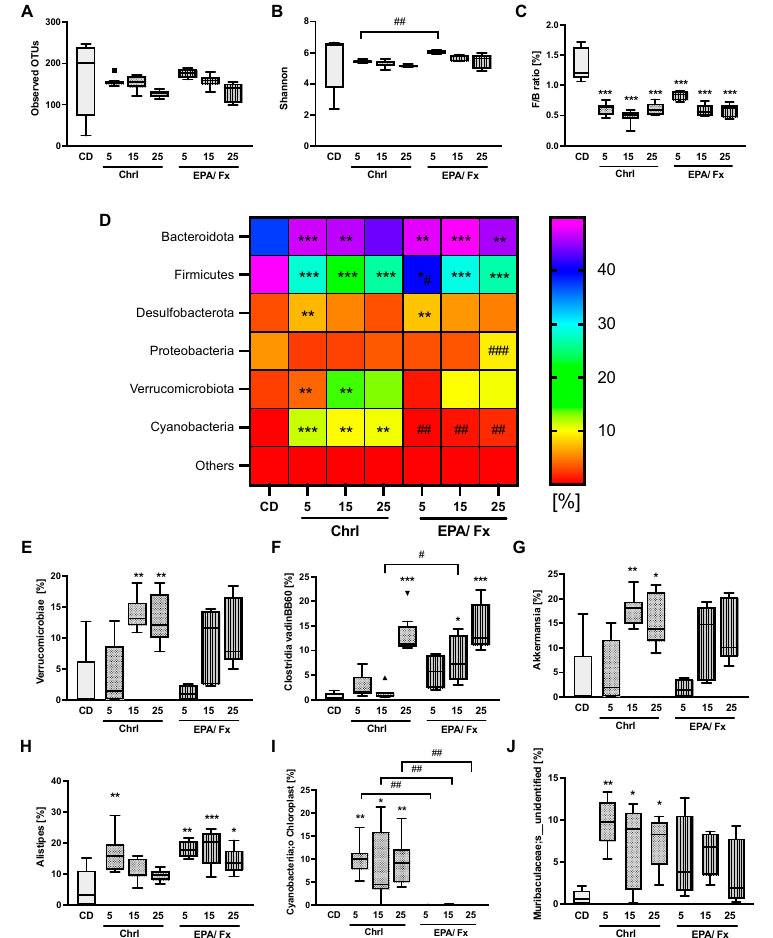
Figure 3. Both PT diets effected changes in the gut microbiome after 14 days of supplementation compared to the CD. The α -diversity, i.e., the species richness (observed OUTs, ( A )), and the species diversity, i.e., the Shannon index ( B ) were not affected. At the phylum level, the F/B ratio was lower in association with PT diets ( C ), and the relative bacterial abundances [%] of Bacteroidota, Firmicutes, and others changed in association with PT diets compared to the CD ( D ). At the class level, the abundance of Verrucomicrobiae was higher in association with Chrl-rich diets ( E ). At the genus level, the abundance of Clostridia_vadinBB60 ( F ), Akkermansia ( G ), and Alistipes changed compared to the CD ( H ). The abundances of Cyanobacteriia chloroplast ( I ) and Muribaculaceae at the species level were higher in association with Chrl-rich diets ( J ). Further results are presented in Supplementary Table S2. Data are shown as box plots with median, 25%, and 75% percentiles and a heat map of the phylum as relative bacterial abundances [%] (CD n = 5; Chrl5 n = 8; Chrl15 n = 7; Chrl25 n = 8; # indicates the difference between Chrl and EPA/Fx diets. */ # p < 0.05, **/ ## p < 0.01, ***/ ### p < 0.001. Abbreviations: OTUs, operational taxonomic units; F/B, Firmicutes/Bacteroidota ratio; for other abbreviations, see Table 1 and Figure